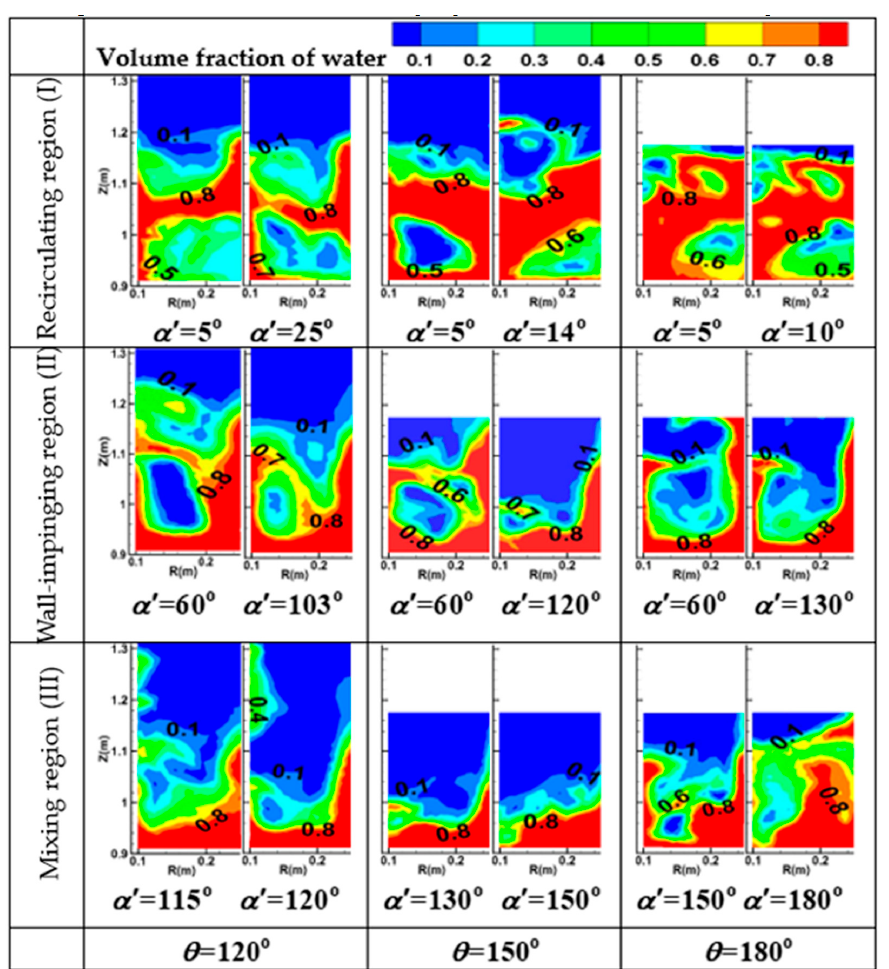
Figure 6. Flow pattern in the cross-section for different configurations, where α (cid:48) is the relative location of the cross-section.